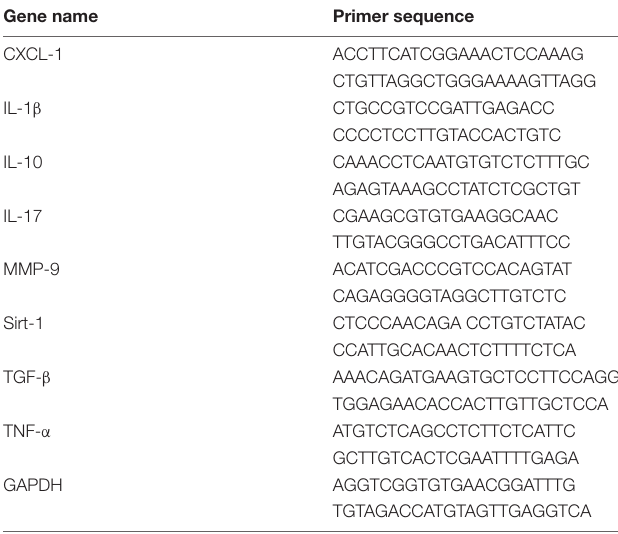
TABLE 1 | PCR primer sequence information.